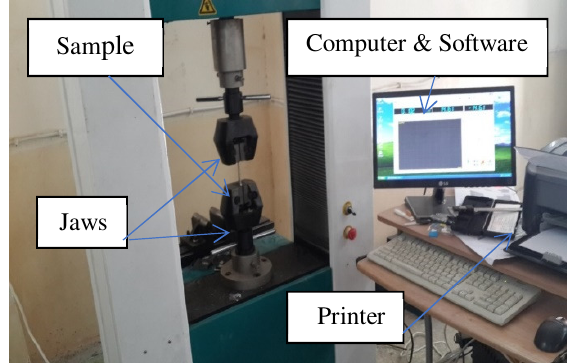
Fig. 2. Standard Tensile Test Sample, all dim. in mm for plane specimen [ASTM E9M].